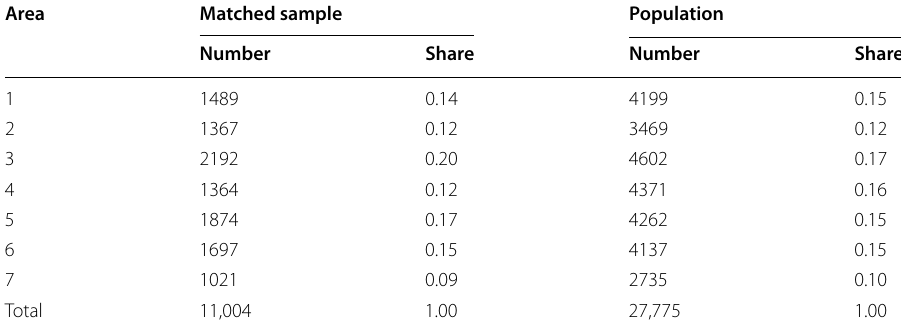
Table 7 Number of researchers in each Area: matched sample and population Area